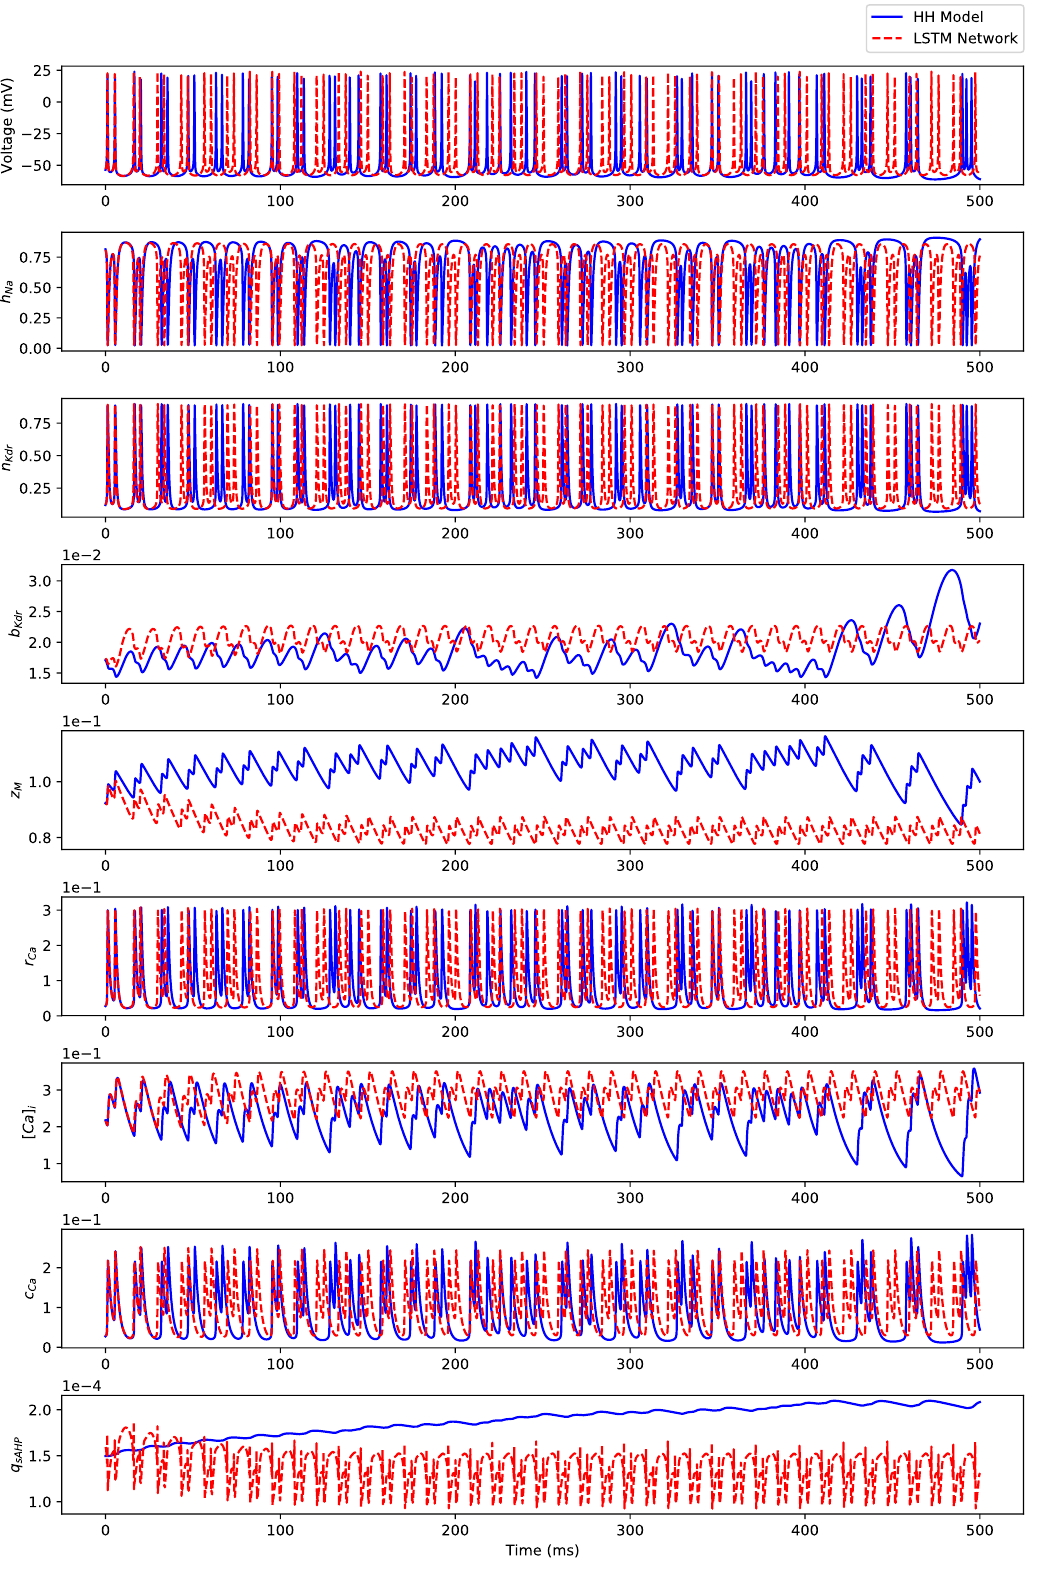
Figure A6. Comparison between the Hodgkin-Huxley model (“HH Model”) states’ dynamics and the iterative predictions of states’ dynamics using the 1 timestep predictive horizon-based deep LSTM neural network (“LSTM Network”) in response to I = 1.5